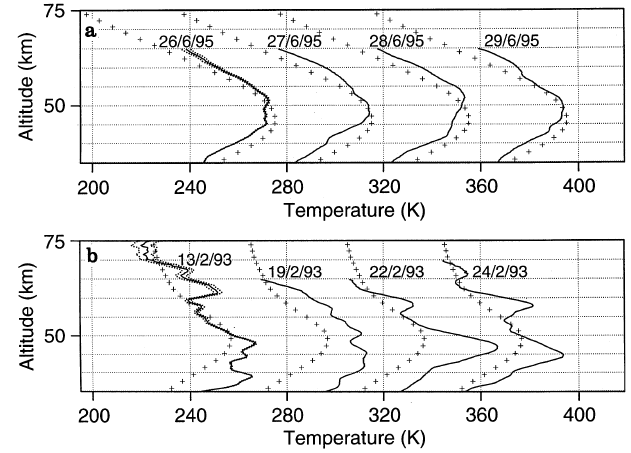
Fig. 1a, b. Mean night-time temperature profiles, represented by full lines , derived from Rayleigh lidar measurements, for a nights of 26–29 June 1995 and b nights of 13, 19, 22, and 24 February 1993. The successive profiles in each group are o(cid:128)set by 40 K. The climatolog- ical mean temperatures for the 2 months taken from the CIRA-1986 model at 50 o N, represented by crosses , are shown for comparison, and also the estimated uncertainties of the mean for the first night of